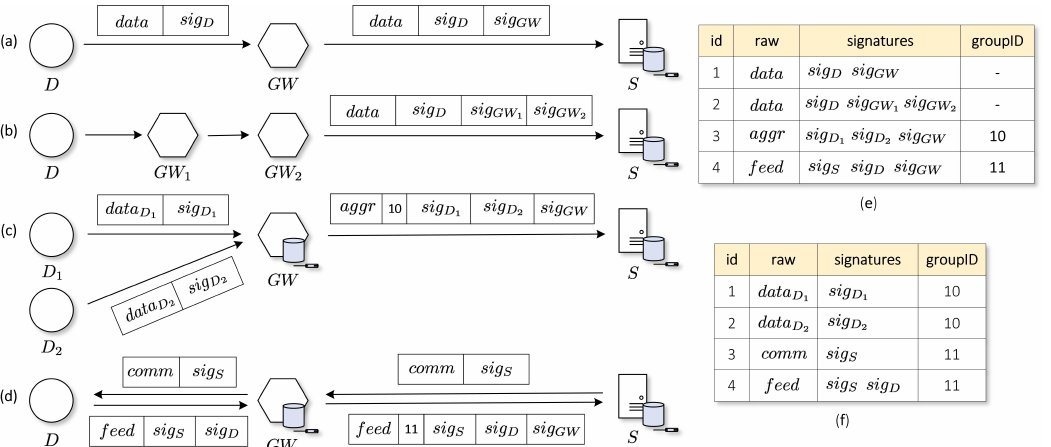
Figure 5. Four scenarios of IoT data flows using chain of signatures: scenarios ( a , b ) are the delivery of a simple IoT data reading from a single IoT device through one or multiple IoT gateways to the IoT service. Scenario ( c ) considers IoT raw data from multiple devices, including a data aggregation scheme performed by the gateway. In scenario ( d ), the IoT service transmits a command to the device, which the device acknowledges as feedback. Finally, ( e , f ) depict the final data stored in the service’s and gateway’s database from scenarios ( a ) to ( d